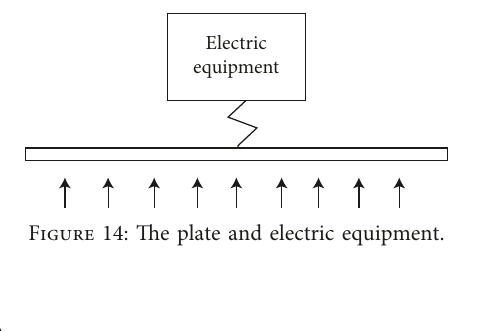
Figure 14: The plate and electric equipment.